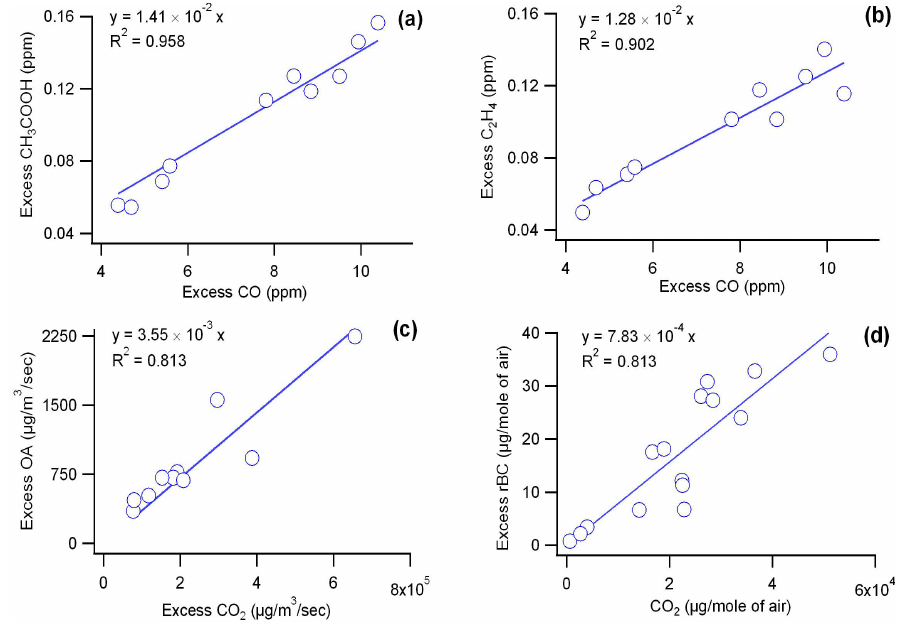
Fig. 4. Emission ratio plots for (a) 1 CH 3 COOH/ 1 CO and (b) 1 C 2 H 4 / 1 CO measured by AFTIR. (c) 1 OA/ 1 CO 2 measured by AMS and NDIR. (d) 1 rBC/ 1 CO 2 measured by SP2 and